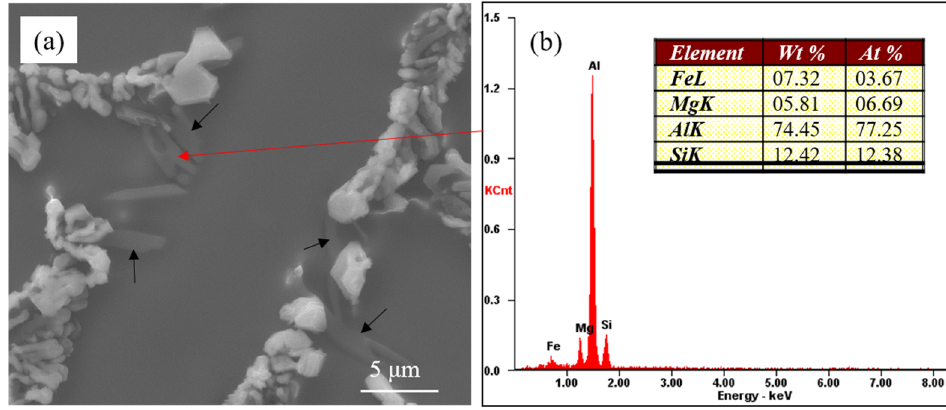
Figure 3. ( a ) Morphology of partially modified eutectic Si and Mg-rich phase in commercial pure Al-7Si-0.4Mg alloy; ( b ) Corresponding EDS results.